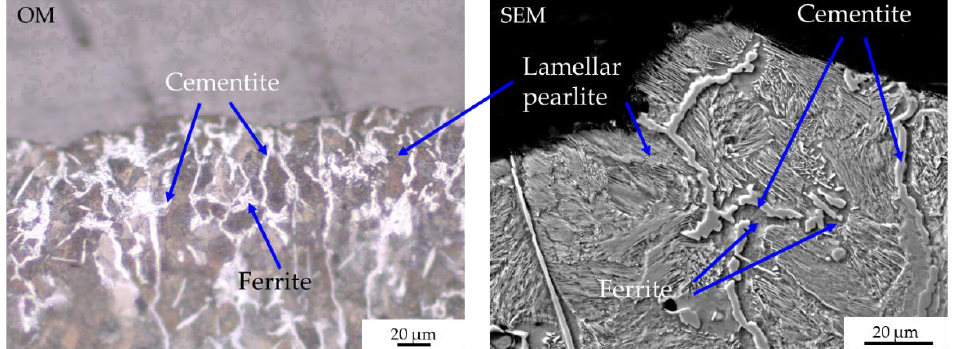
Figure 3. Magnification of zone 1 (sintering with graphite foils without coating): OM (on the left ) and SEM (on the right ) images after chemical etching.